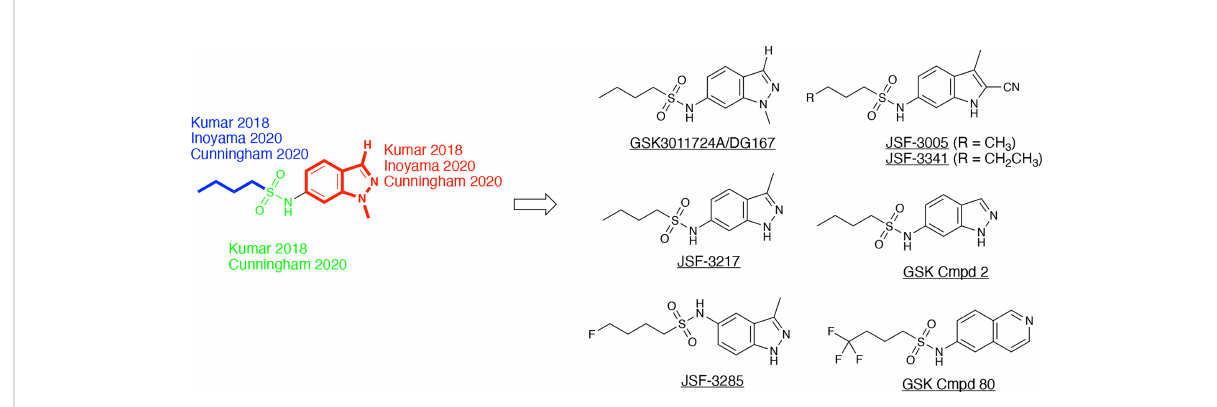
FIGURE 8 DG167 and its analogs. The derivatives, as referenced herein, are noted with regard to alterations in the heterocyclic core and sulfonamide